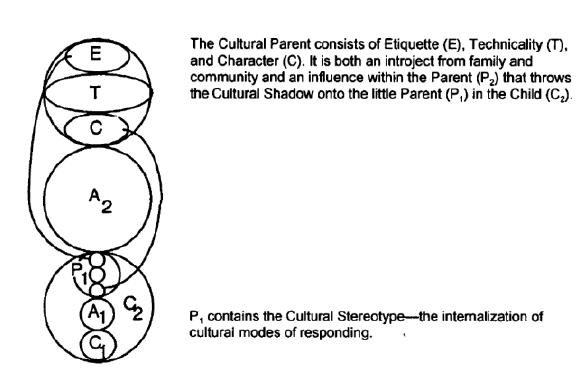
Figure 17: Cultural Parent and Cultural Shadow (Drego, 1996,